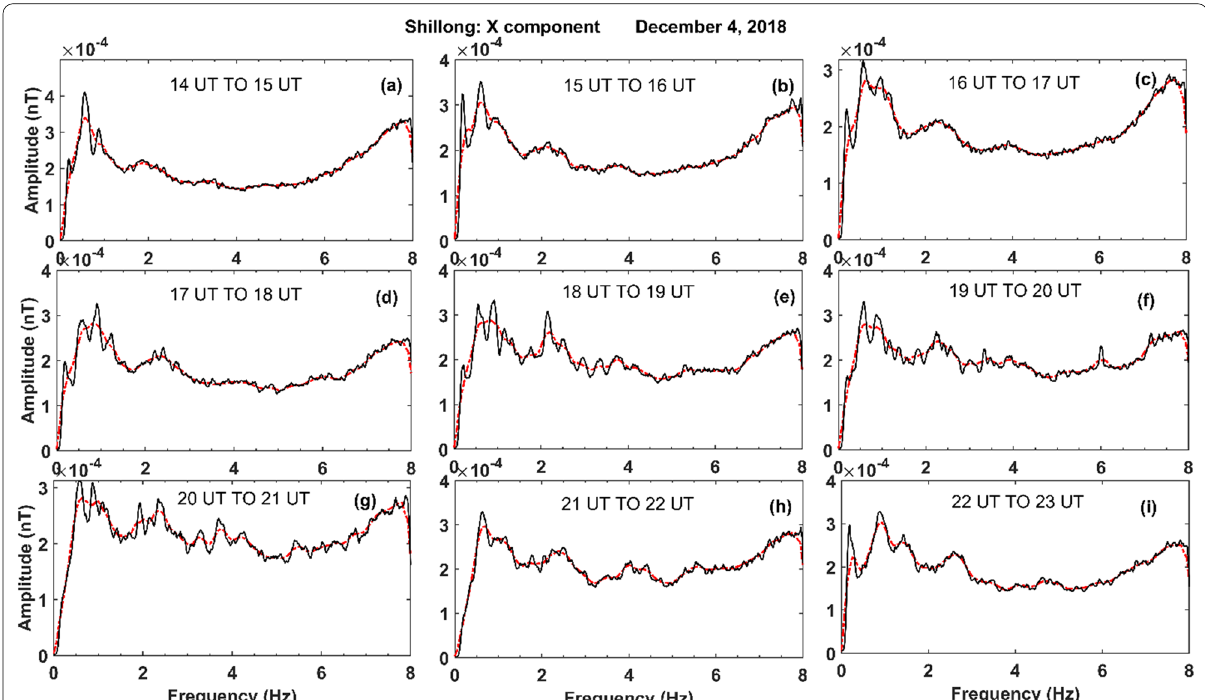
Fig. 3 Hourly static power spectra of B x component showing the frequency separation for both small and large Spectral Resonance Structures. The solid black line is the power spectra with frequency resolution of 0.0156 Hz and dashed red line denotes the frequency resolution of 0.0625